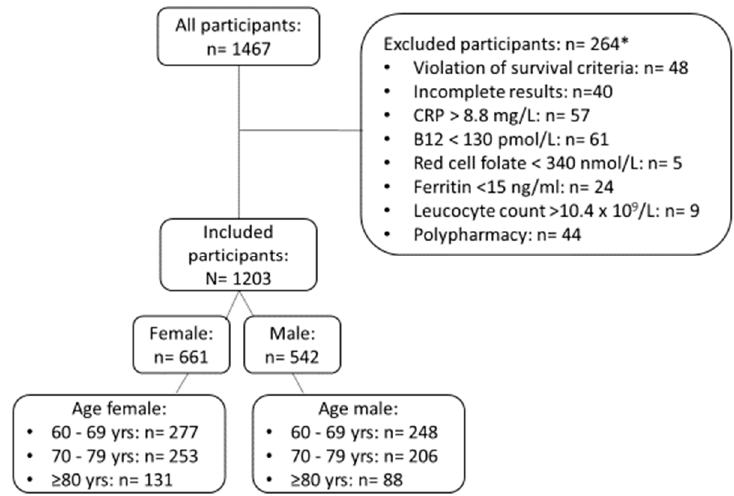
Figure 1. Inclusion algorithm for determination of direct reference intervals for platelet counts in seniors. * One patient could have more than one disorder. CRP = c-reactive protein.